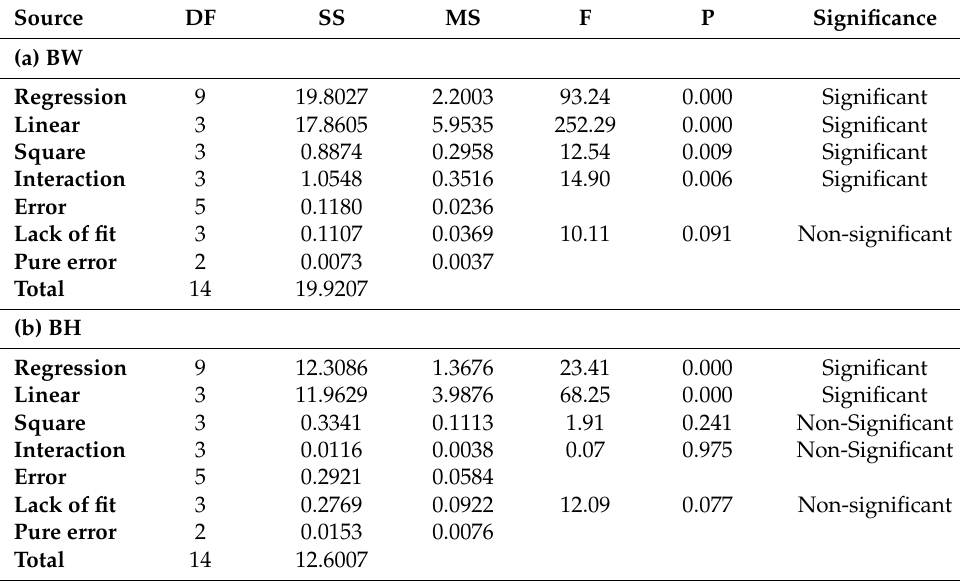
Table 4. ANOVA for (a) BW, and (b)